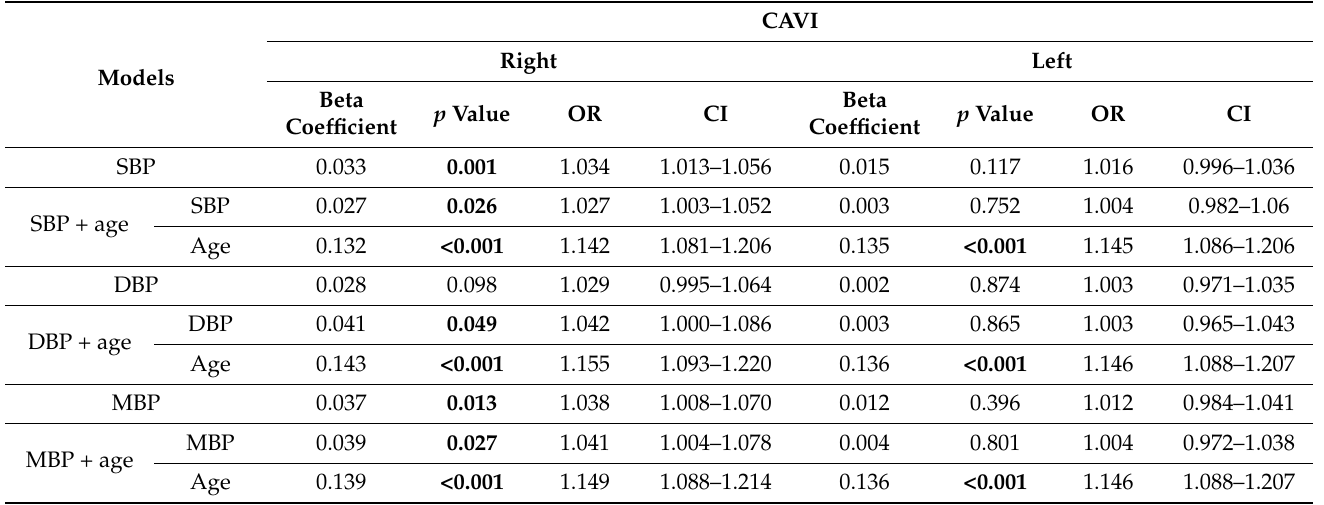
Table 6. Logistic regression models to assess the independency of the association between blood pressure indices and CAVI.